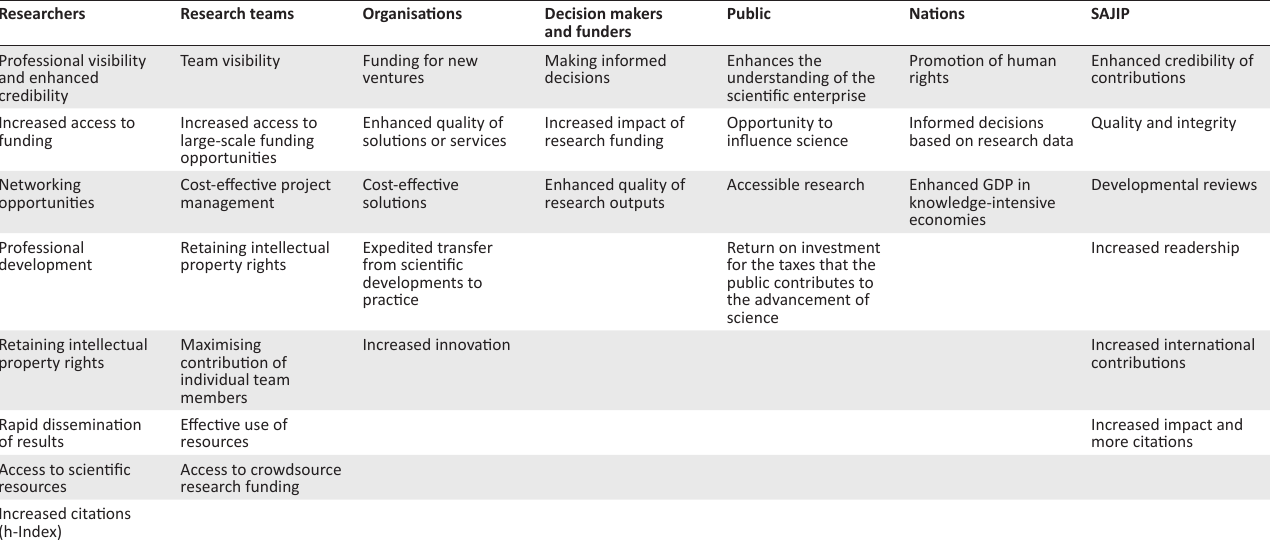
TABLE 1: Benefits of open science practices for key